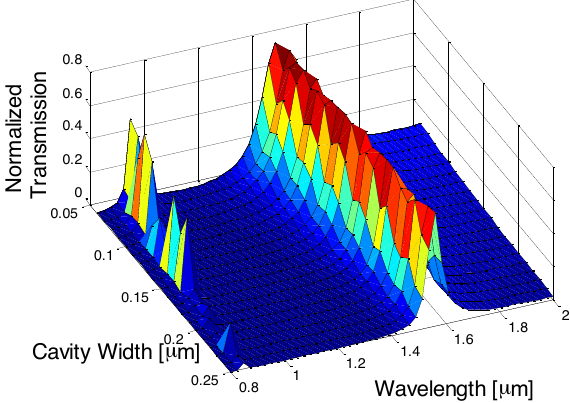
Fig.4. Tuning the width of the resonator controlling the resonance wavelength